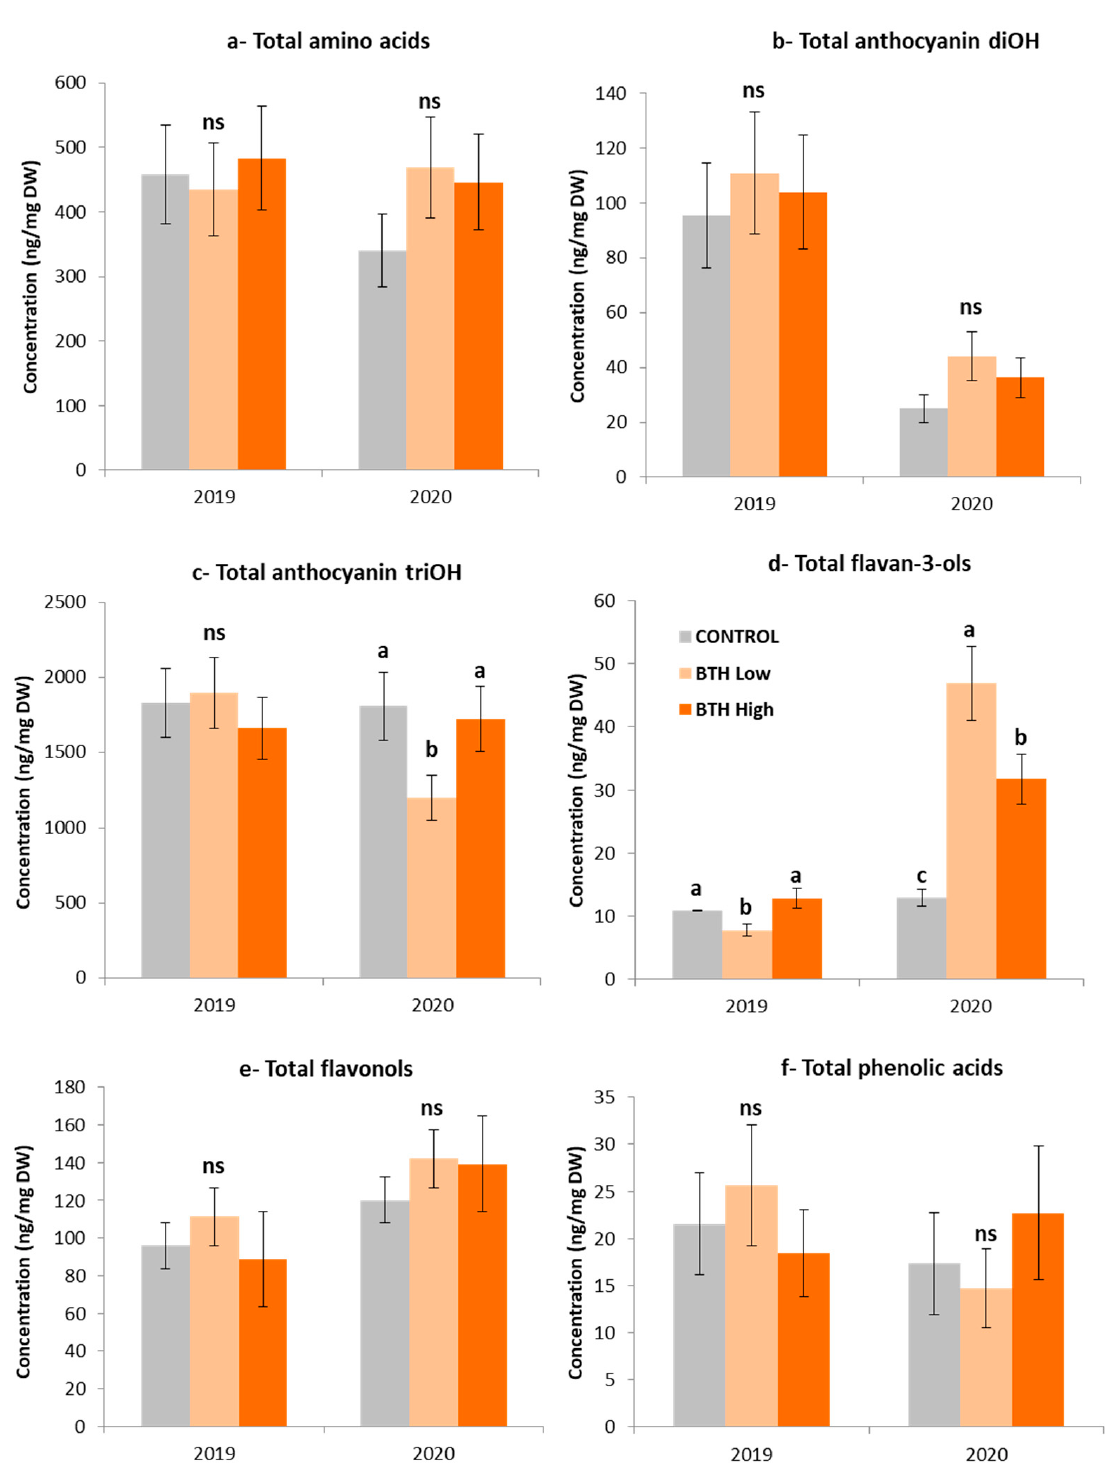
Figure 2. Total concentrations of amino acids ( a ), anthocyanins diOH ( b ), stilbenoids ( c ), flavan-3-ols ( d ), flavonols ( e ), and phenolic acids ( f ) in Mouhtaro berries at Harvest (3rd sampling) stage in 2019 and 2020 treated with benzothiadiazole: control (grey), low concentration of benzothiadiazole (pale orange), and high concentration of benzothiadiazole (dark orange). Error bars represent the standard deviations. Different letters indicate significant differences. No significant difference (ns) was found between values with the same letters (one-way ANOVA, p -value > 0.05).